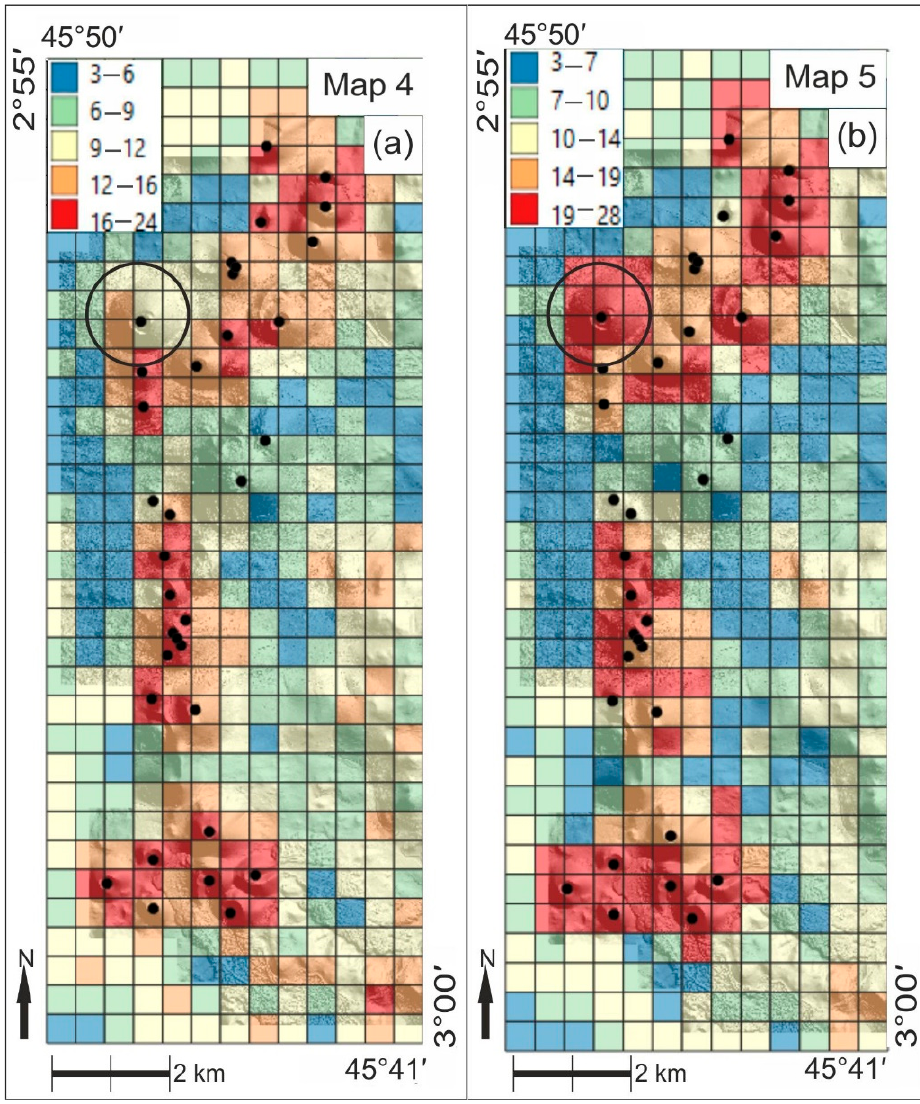
Figure 10. Geodiversity maps of the examined area. ( a ) Geomorphology subindex values were calculated with the addition of two variables to the original methodology plus geomorphons: cone presence in a certain cell (score 0 or 1) and the number of different sectors in a certain cell (Map 4). ( b ) Geomorphology subindex values were calculated with the addition of two variables to the original methodology plus geomorphons: cone presence in a certain cell (score 0 or 1) and the median of sector values in a certain cell (Map 5). Black dots indicate the scoria cone centers. Table 2. Summary table of the used minimum and maximum subindices. The original values (Map 1) [4] are supplemented by the new subindex we